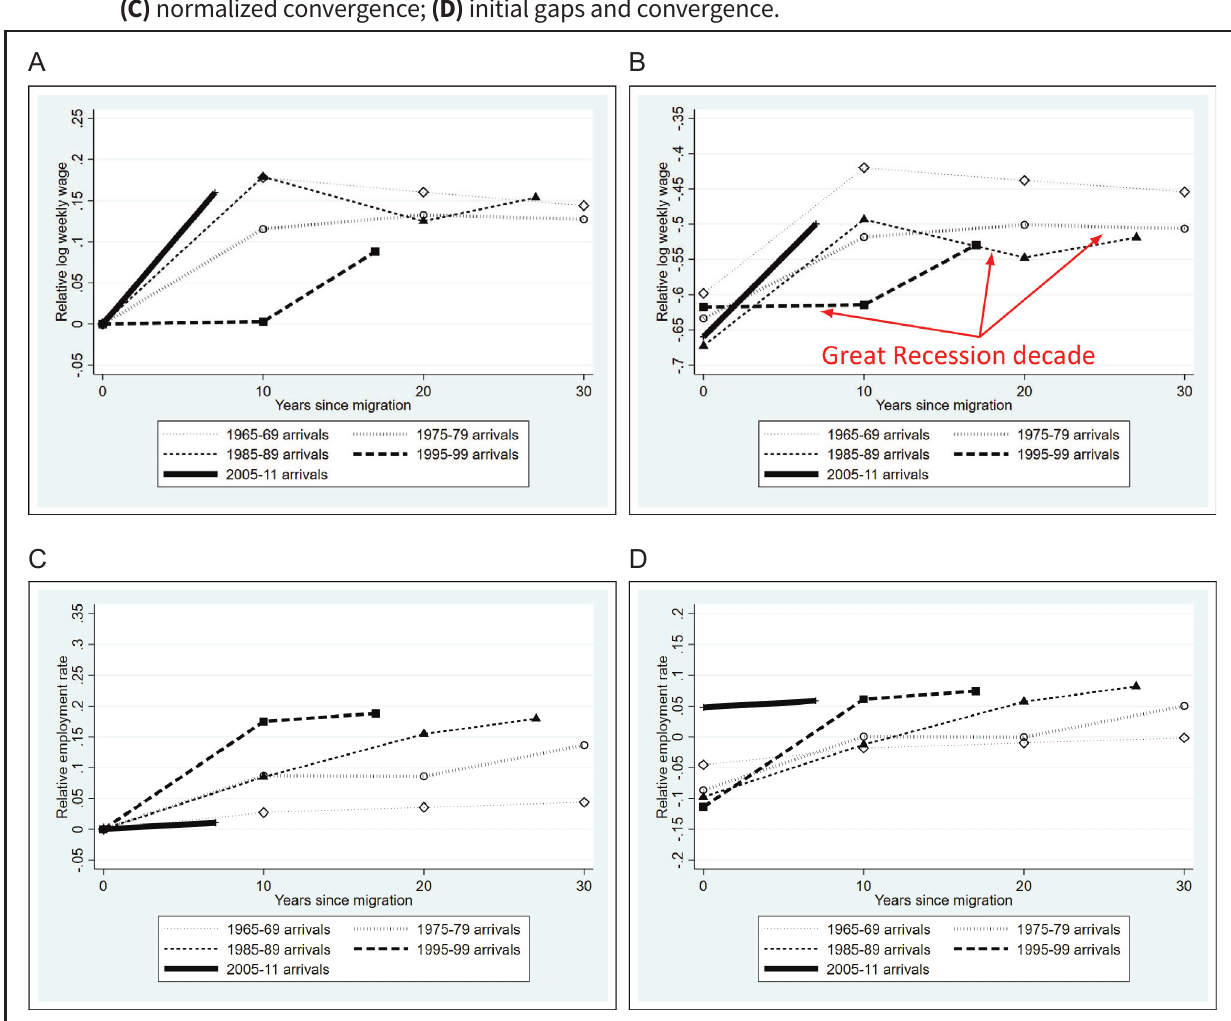
Figure 2 Age-adjusted convergences for the relative log weekly earnings and employment rates of Mexican and Central American immigrant cohorts: (A) normalized convergence; (B) initial gaps and convergence; (C) normalized convergence; (D) initial gaps and